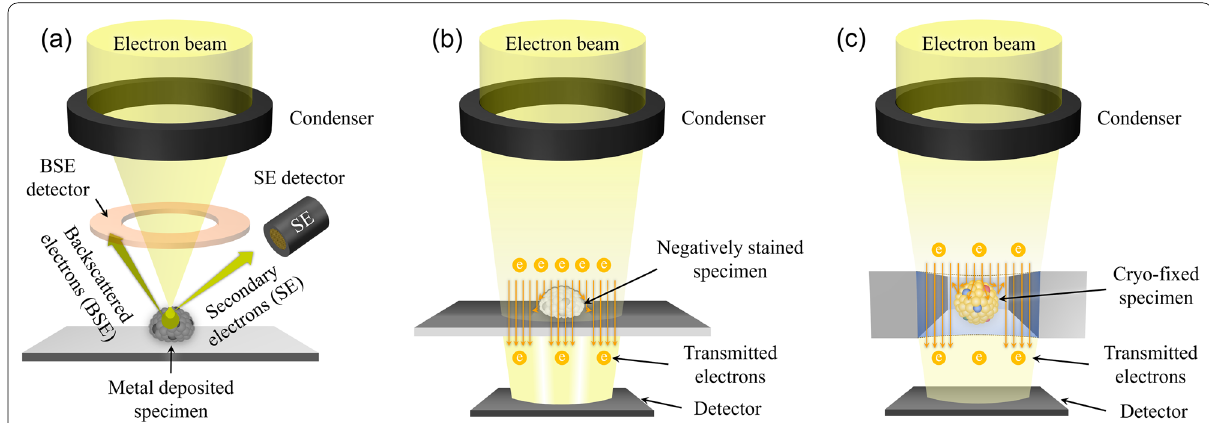
Fig. 4 Three types of electron microscopy (EM) techniques. a Scanning electron microscopy (SEM) detects backscattered electrons (BSE) or secondary electron (SE) signals of EVs deposited with metal film. b Transmission electron microscopy (TEM) acquires an image by detecting the electrons transmitted through the negatively stained EVs with heavy metal according to the electron transmittance. c The principle of cryo-TEM is similar to that of TEM, but it freezes EVs to rapidly fix them to maintain their natural spherical